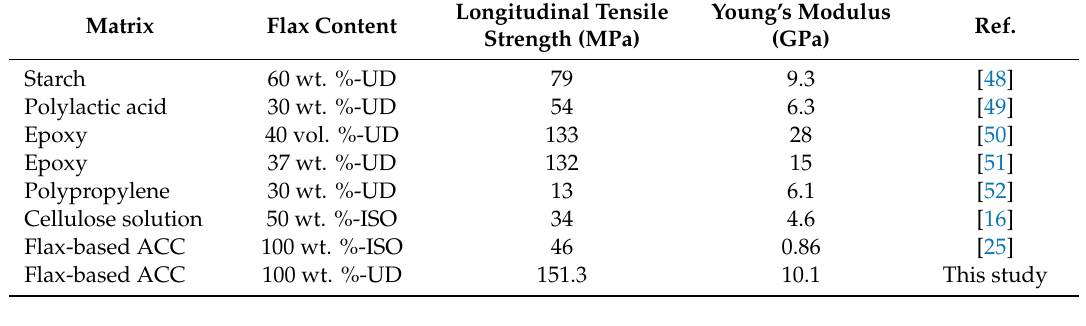
Table 3. Comparison of the mechanical properties of unidirectional (UD) flax-reinforced polymer composites, isotropic (ISO) flax-based ACCs and the strongest unidirectional flax-based ACC obtained in this study.